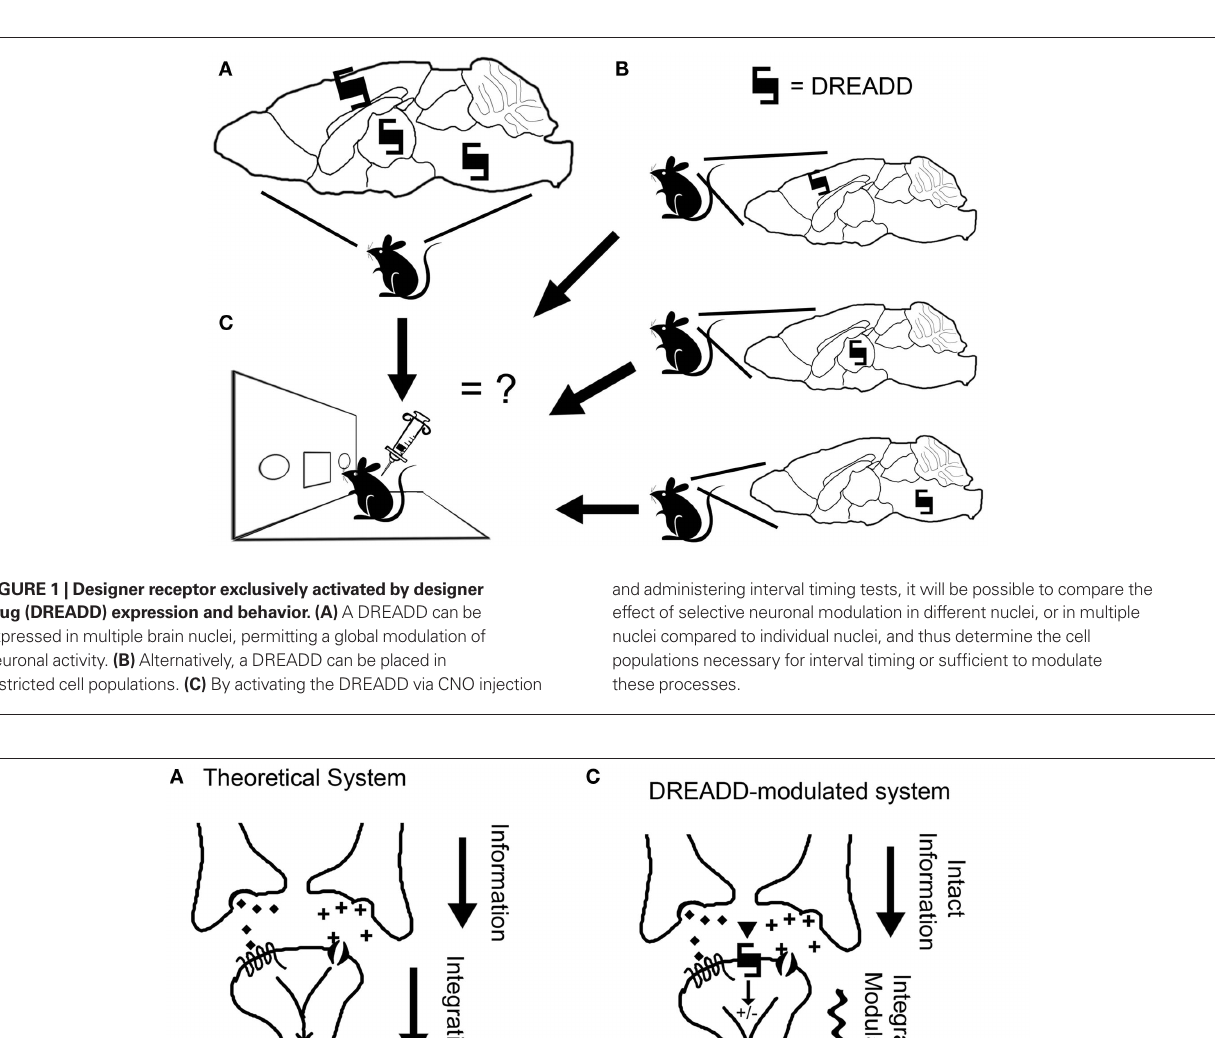
post-synaptic neuron integrates information from multiple inputs. (B) In a classical pharmacological manipulation, an agonist is administered with the intent to modulate the post-synaptic neuron responsible for the integration of